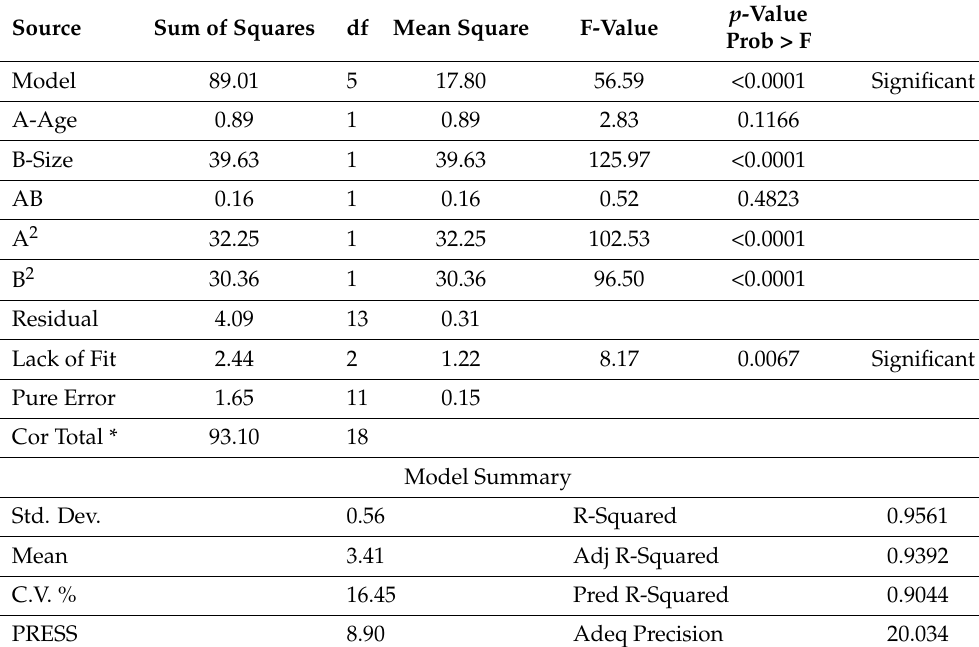
Table 1. Analysis of variance (ANOVA) and determination coefficients for the quadratic nonlinear model for dry cell growth [Partial sum of squares—Type III].